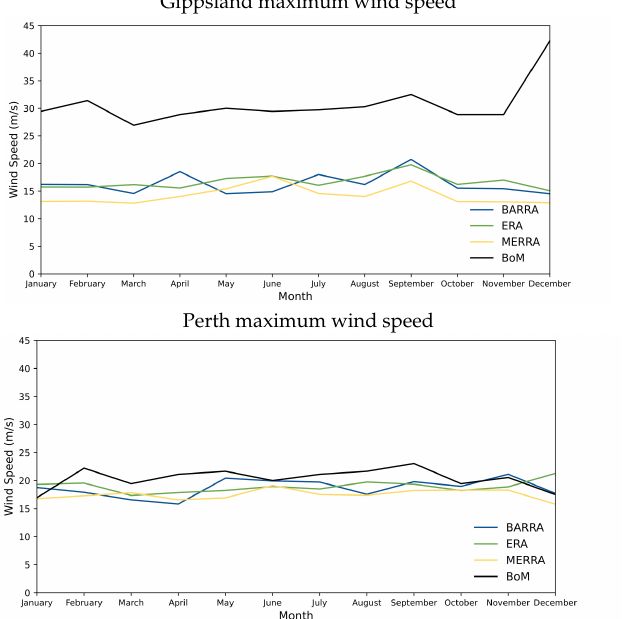
Figure 11. Comparison between predicted maximum wind speeds and BoM weather station gust data for Gippsland and